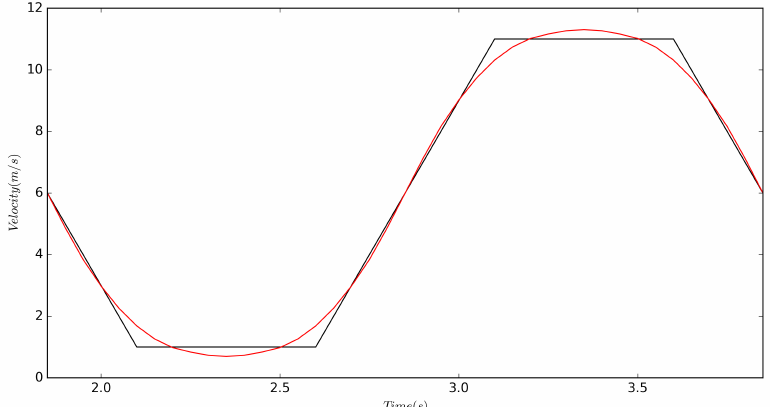
Figure 3. A zoomed plot of the periodic signal for V inlet ( t ) during one period. Black and red lines represent the raw user input signal and smoothed signal,